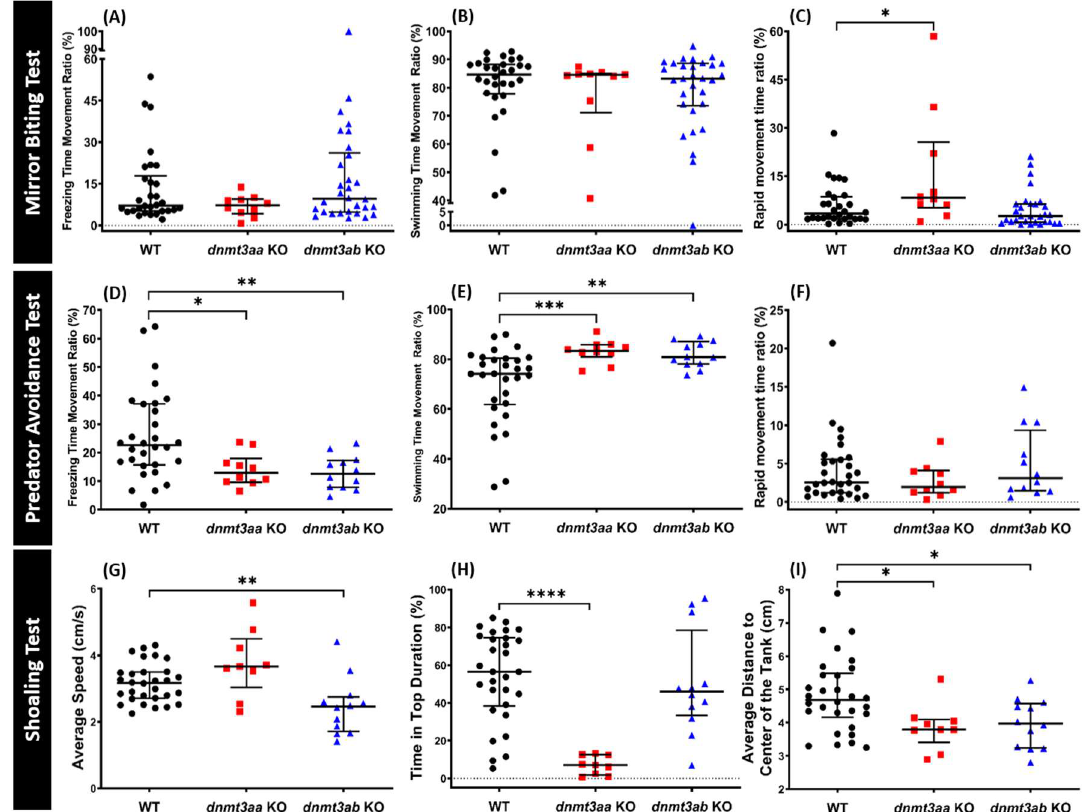
Figure A1. Comparison of mirror biting, predator avoidance, and shoaling endpoints among the WT, dnmt3aa KO, and dnmt3ab KO mutant fish. ( A , D ) Freezing time movement ratio, ( B , E ) swimming time movement ratio, and ( C , F ) rapid movement time ratio measured in mirror biting ( n = 30 for wild type and dnmt3ab KO fish; n = 10 for dnmt3aa KO fish) and predator avoidance ( n = 30 for wild type; n = 10 for dnmt3aa KO fish; n = 12 for dnmt3ab KO fish) tests, respectively. ( G ) Average speed, ( H ) time in top duration, and ( I ) average distance to the center of the tank measured in the shoaling test ( n = 30 for wild type; n = 9 for dnmt3aa KO fish; n = 12 for dnmt3ab KO fish). The data are expressed as the median with interquartile range and analyzed by Mann–Whitney test (* p < 0.05, ** p < 0.01, *** p < 0.001, ****, p < 0.0001).